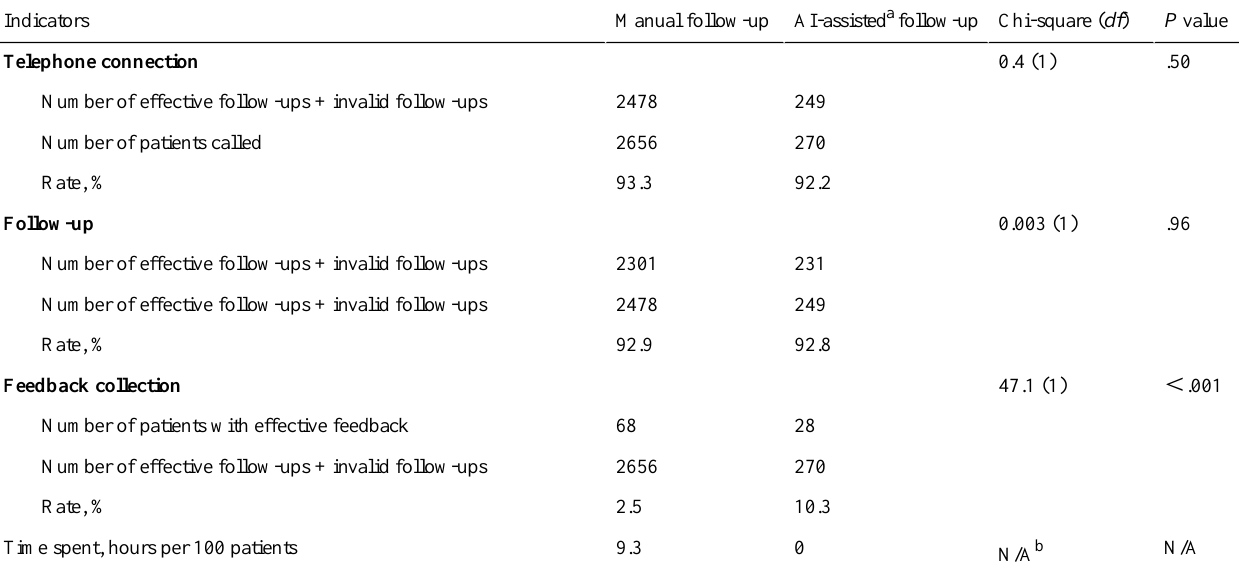
Table 3. Comparison of manual and artificial intelligence–assisted follow-up